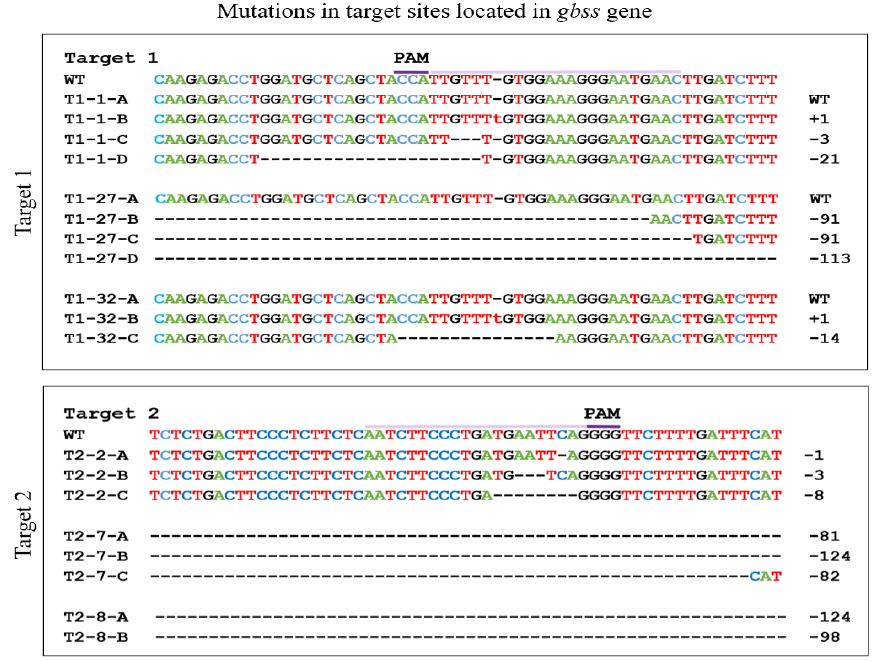
Figure 4. Nature of mutations ascertained by Sanger sequencing of clones obtained from PCR products that were amplified from the genomic DNA of leaves from three events per target site that were characterized extensively. Overlined: target sequence in the native gbss gene; dark purple line: PAM (protospacer adjacent motif) sequence; WT: wild-type sequence; T#-#-alphabet: the target number, the knockout event number for each target and the type of mutation obtained.